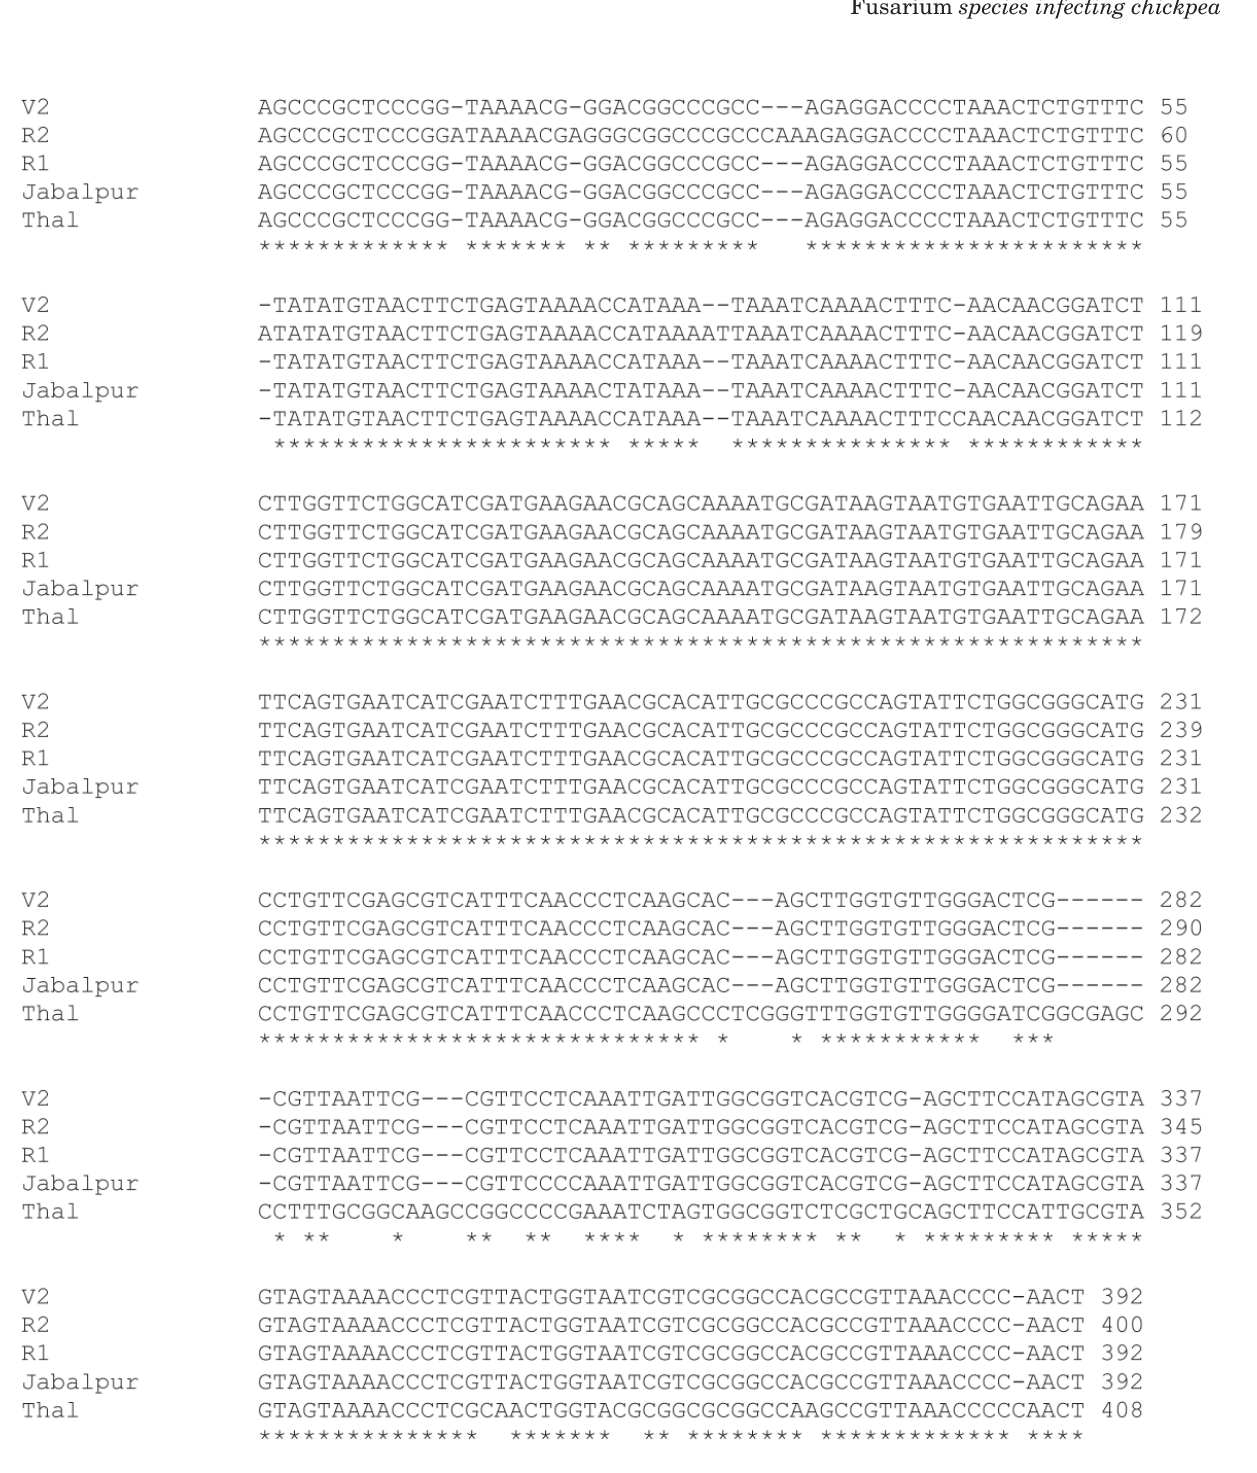
Fig. 2. Alignment of ribosomal DNA sequences from five isolates of Fusarium obtained from chickpea. Note the differences of the Thal isolate from the other isolates, particularly between bases